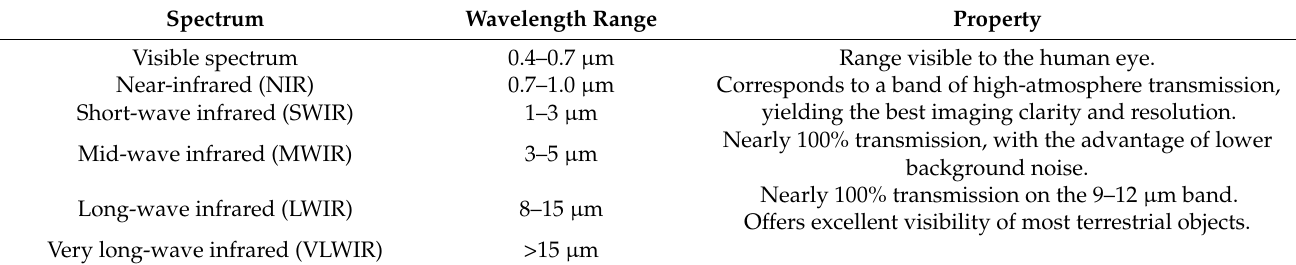
Figure 2. Camera sensor type responding to different wavelengths. Table 1. Spectrum wavelength range and